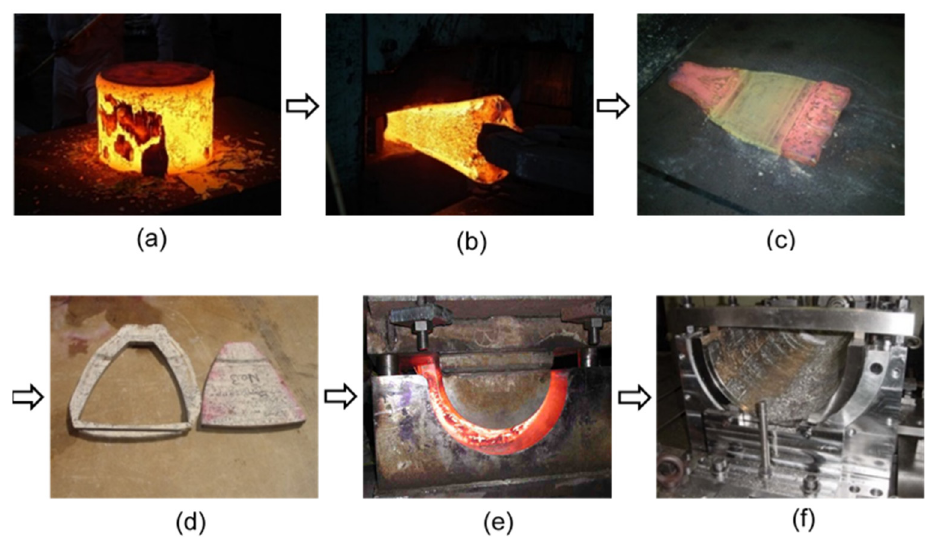
Figure 3. Photographic images showing some of the process used to fabricate a commercial product. ( a ) Upset forging, ( b ) width-adjustment forging, ( c ) plate material after forging, ( d ) trimming by water-jet cutting, ( e ) forming by hot-forging, and ( f ) machining.